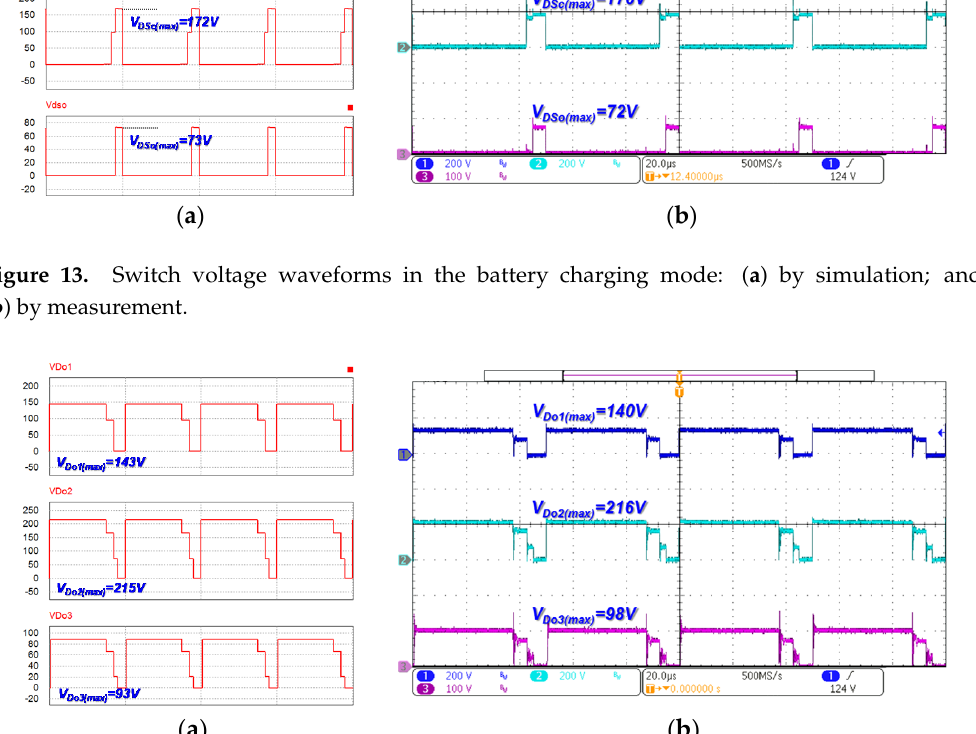
Figure 14. Diode voltage waveforms in the battery charging mode: ( a ) by simulation; and ( b ) by measurement.